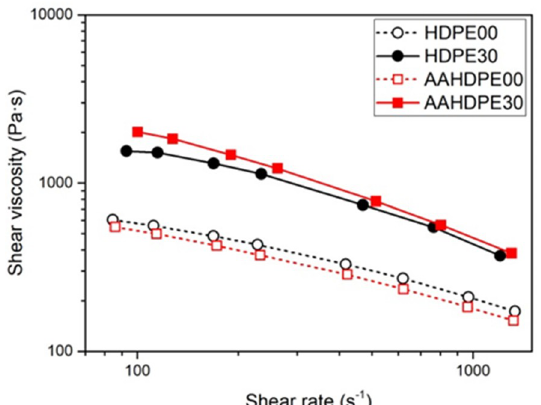
Figure 5. Shear viscosity curves as a function of shear rate measured in a round die capillary rheometer at 160 °C for HDPE00, HDPE30, AAHDPE00 and AAHDPE30. Lines are included to facilitate the visualization of the results.